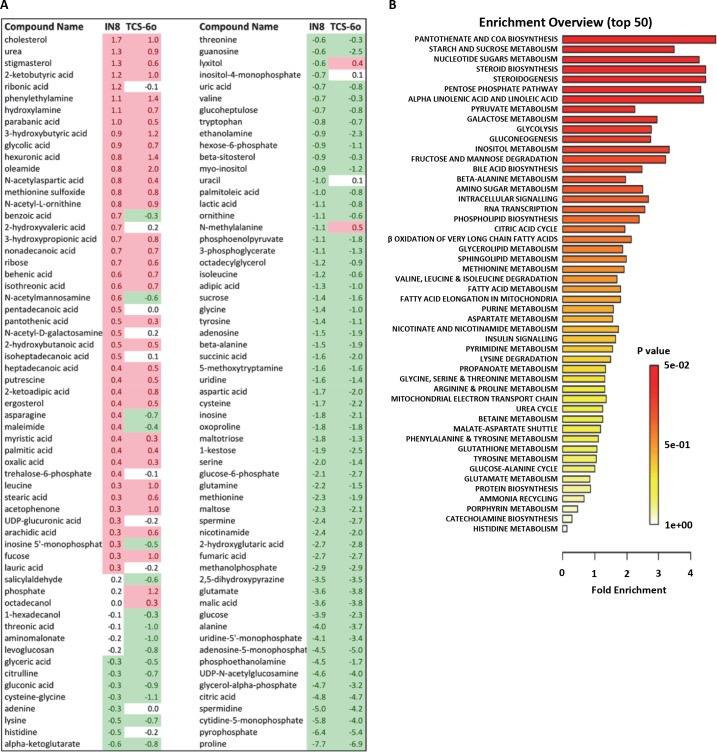
Identification of midgut metabolites in JNK SMI-treated A. stephensi with fold concentrations and metabolite set enrichment analysis.(A) Midgut metabolites identified by GC-MS/MS. Controls (n = 3) and treated samples (n = 3 per treatment) were processed to identify midgut metabolites. The relative concentrations of each metabolite were divided by the average of control levels and the resulting ratio was expressed as the LOG2. Cut-off for over-abundance was considered ≥ 0.3 whereas concentrations below that of controls were taken as ≤-0.3. (B) Summary plot for quantitative enrichment analysis (QEA). The QEA was performed using a generalized linear model to estimate a Q-statistic for each metabolite set, which describes the correlation between compound concentration and treatment. The right panel summarizes the average Q statistics for each metabolite in the input set.